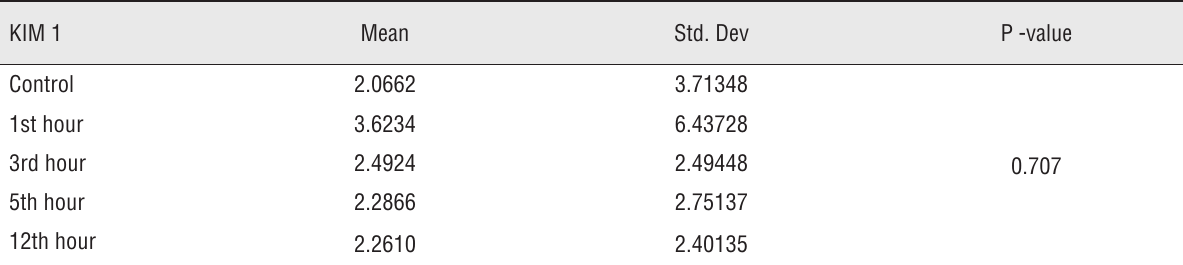
Table 3 - Time-linked variation in KIM-1 (ng/mL) measured in urine. KIM 1